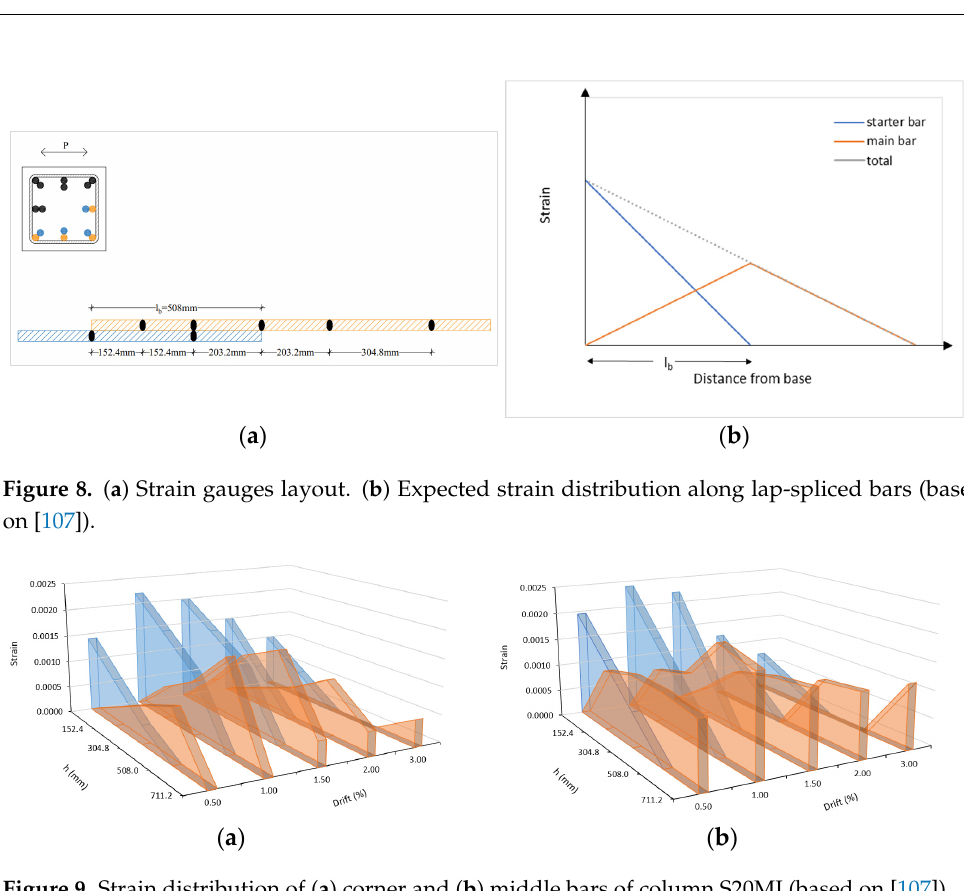
Figure 9. Strain distribution of ( a ) corner and ( b ) middle bars of column S20MI (based on [107]).